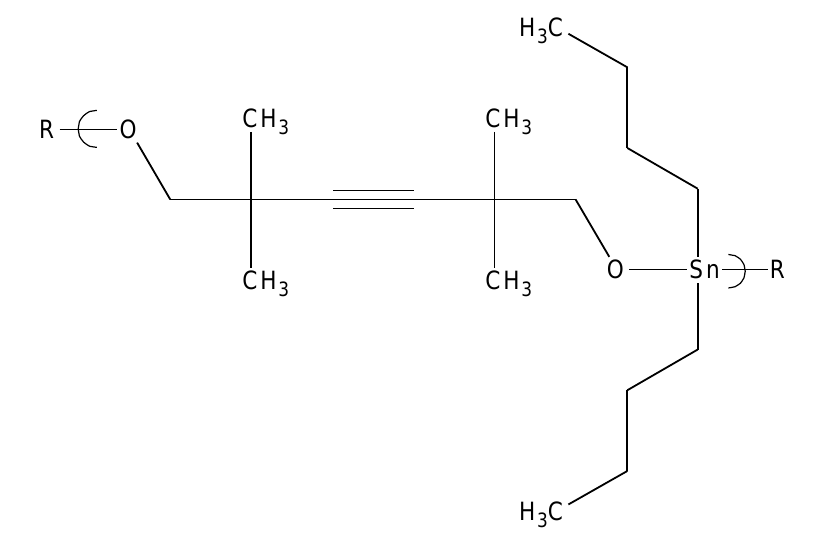
Figure 3. Repeat unit for the product of dibutyltin dichloride and